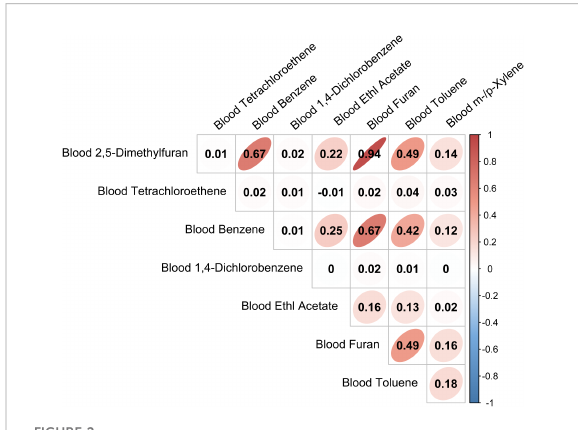
FIGURE 2 Heatmap of Pearson correlation analysis among speci fi c